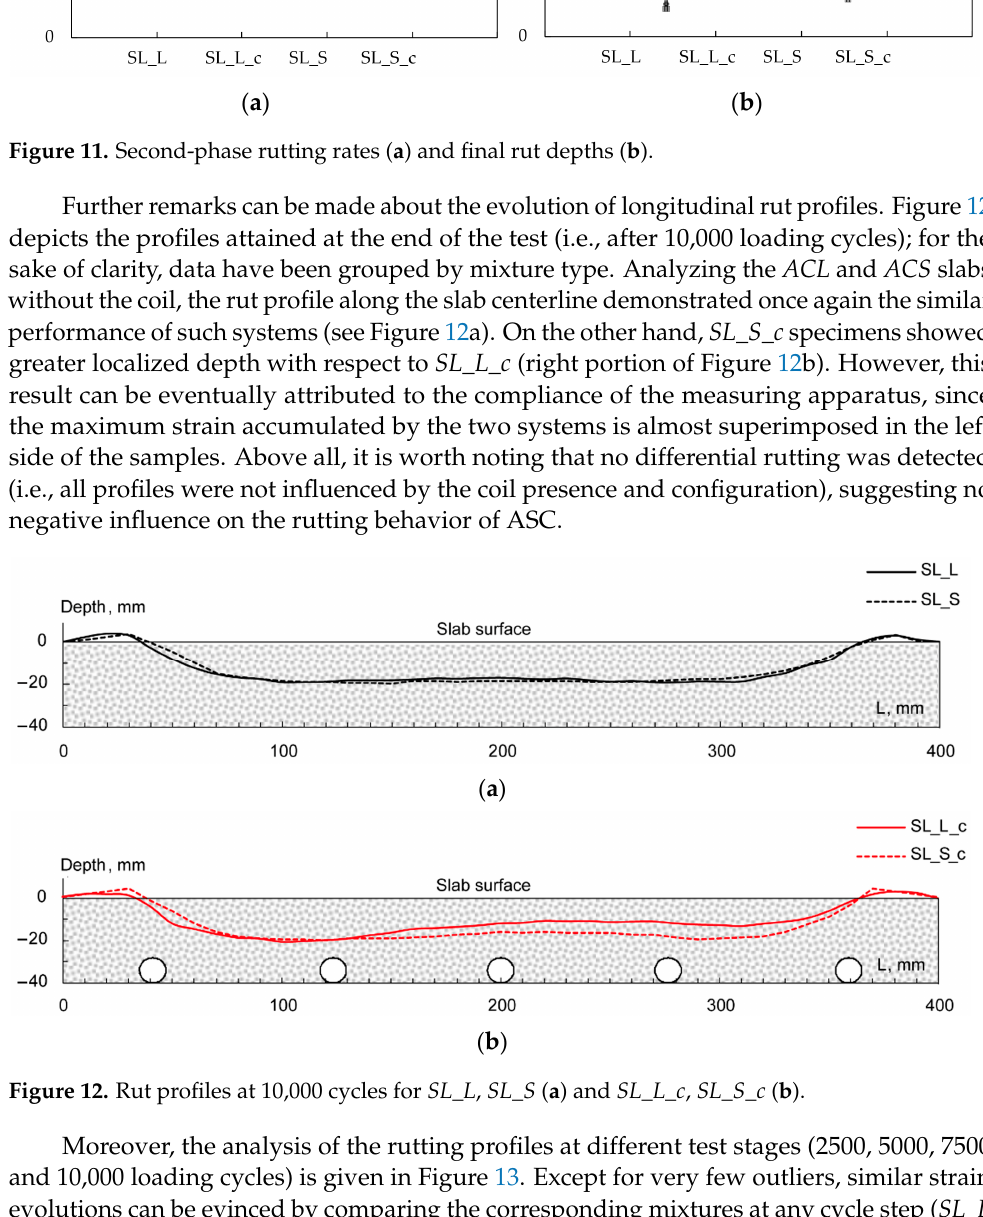
Figure 11. Second-phase rutting rates ( a ) and final rut depths ( b ).